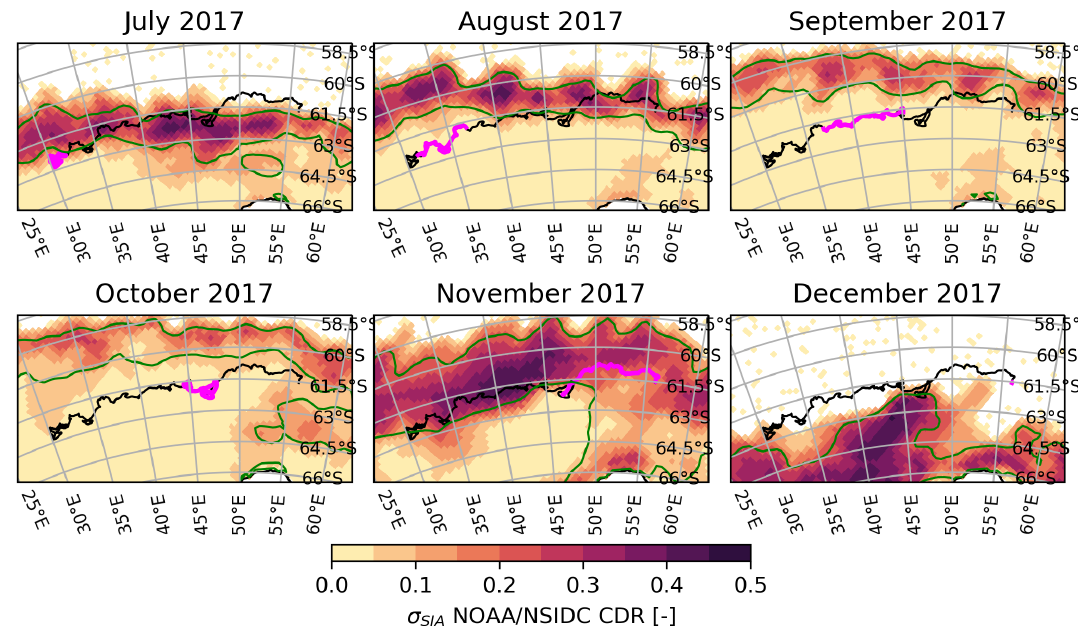
Figure 6. Trajectory of the ice-tethered, non-floating drifter studied by Womack et al. (2022) in winter 2017 (from 4 July 2017 to 1 December 2017, black line) overlain on the σ SIA indicator field (shading) and the 0.15–0.80 SIC range (green contours) from the NOAA/NSIDC CDR. The magenta lines indicate the paths followed during each